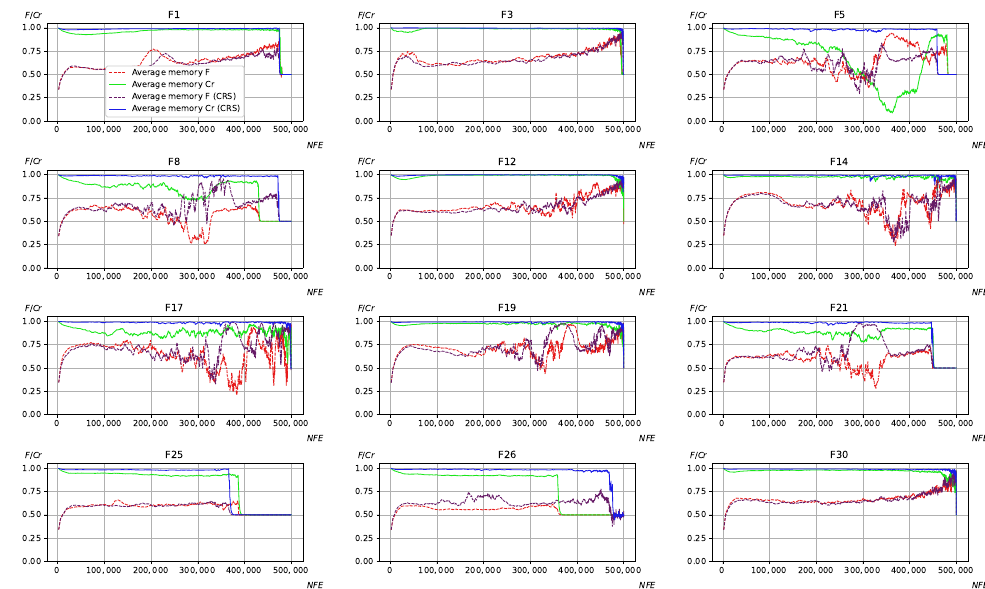
Figure 6. Parameter adaptation with and without crossover rate sorting, L-NTADE, CEC 2017, 50 ∗ D